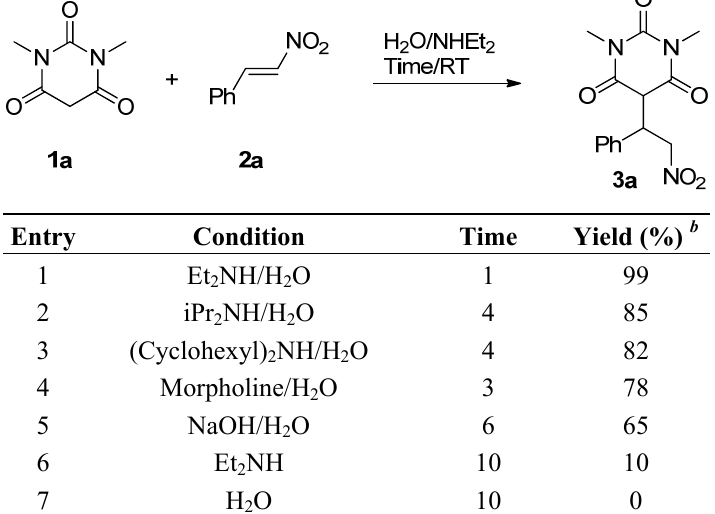
NH/H O 1 99 2 2 NH/H O 4 85 2 2 NH/H O 4 82 2 2 O 3 78 2 O 6 65 2 2